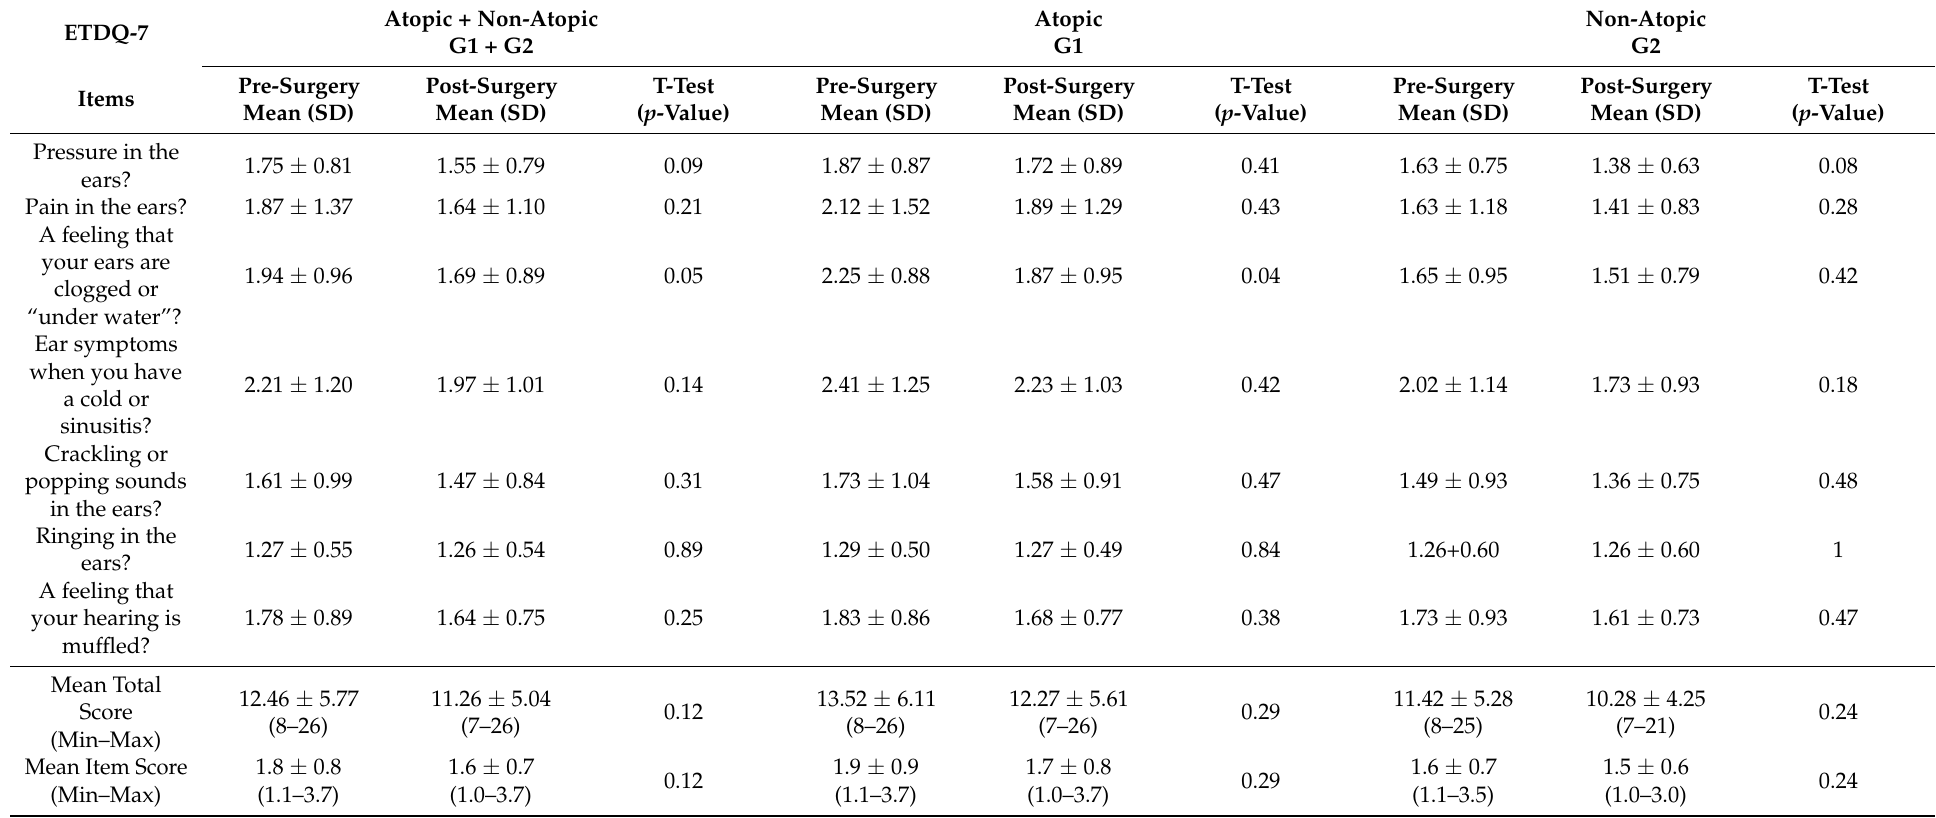
Table 1. Eustachian Tube Dysfunction Questionnaire-7 (ETDQ-7) scores before and after